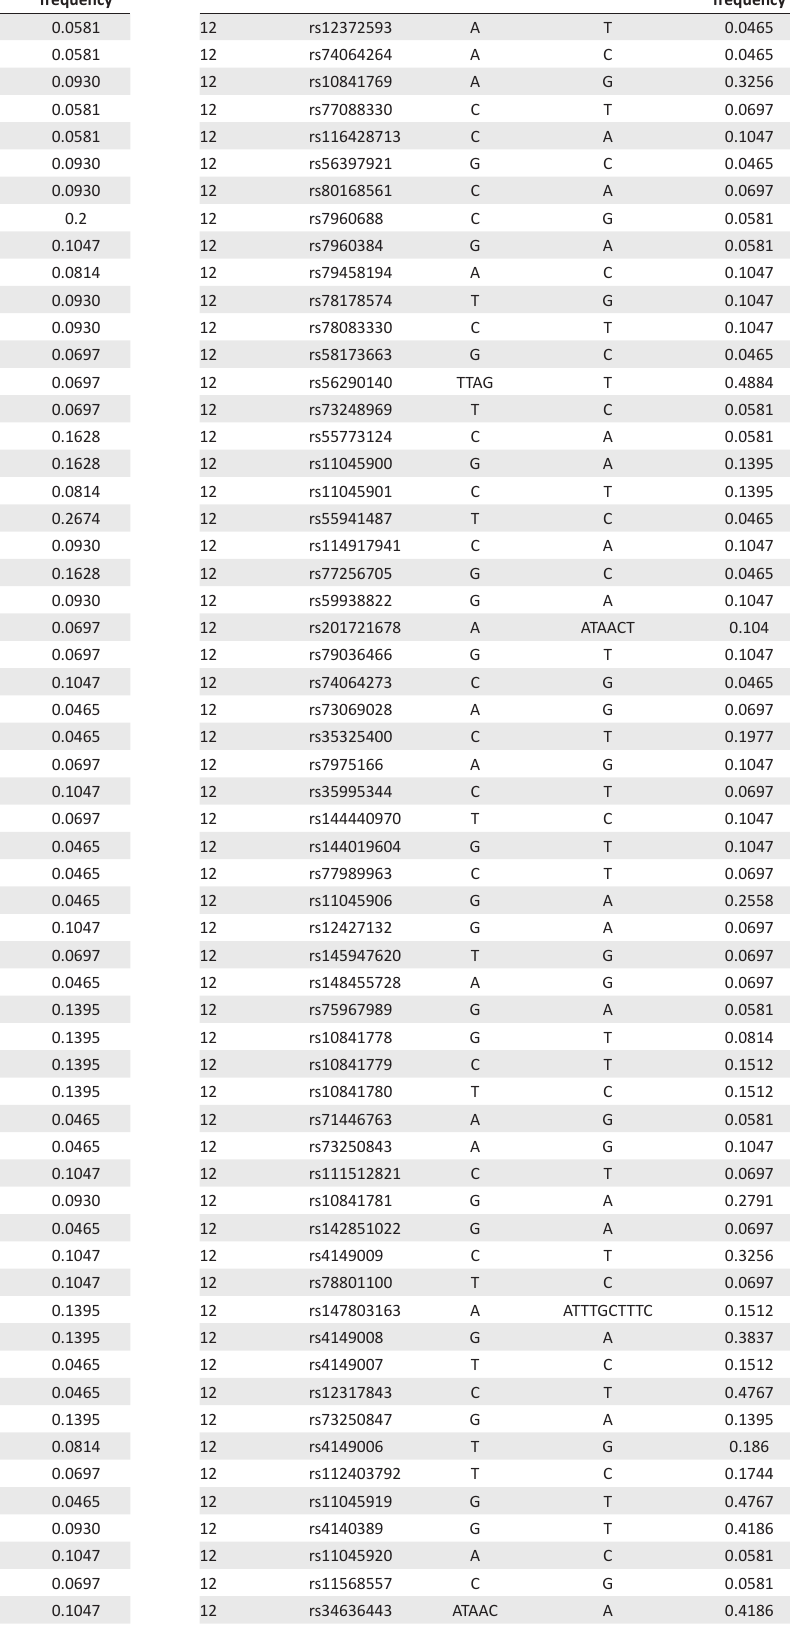
Table 1-A1 (Continues...): Minor allele frequencies for 1846 polymorphisms in 43 black South Africans. Chromosome Polymorphism Minor allele Major allele